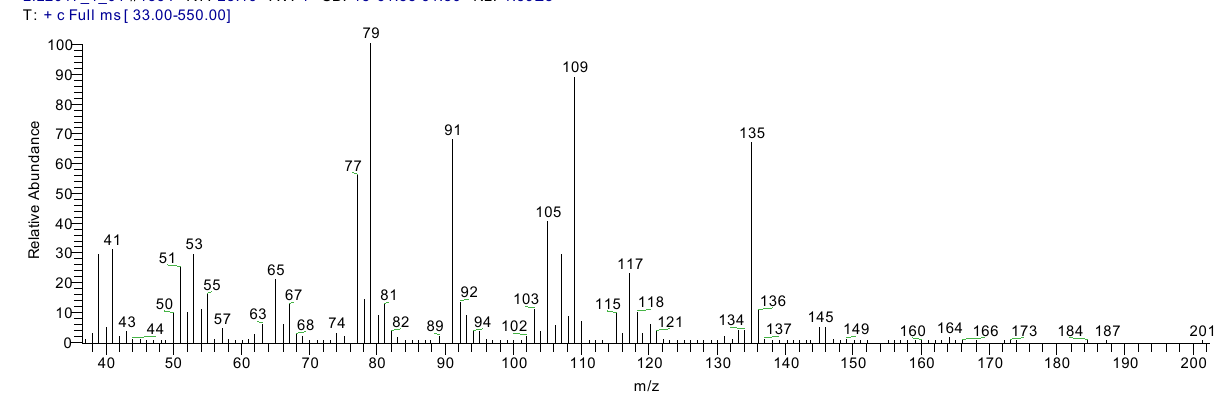
Figure 2: GC-MS chromatogram of unidentified constituent (RI